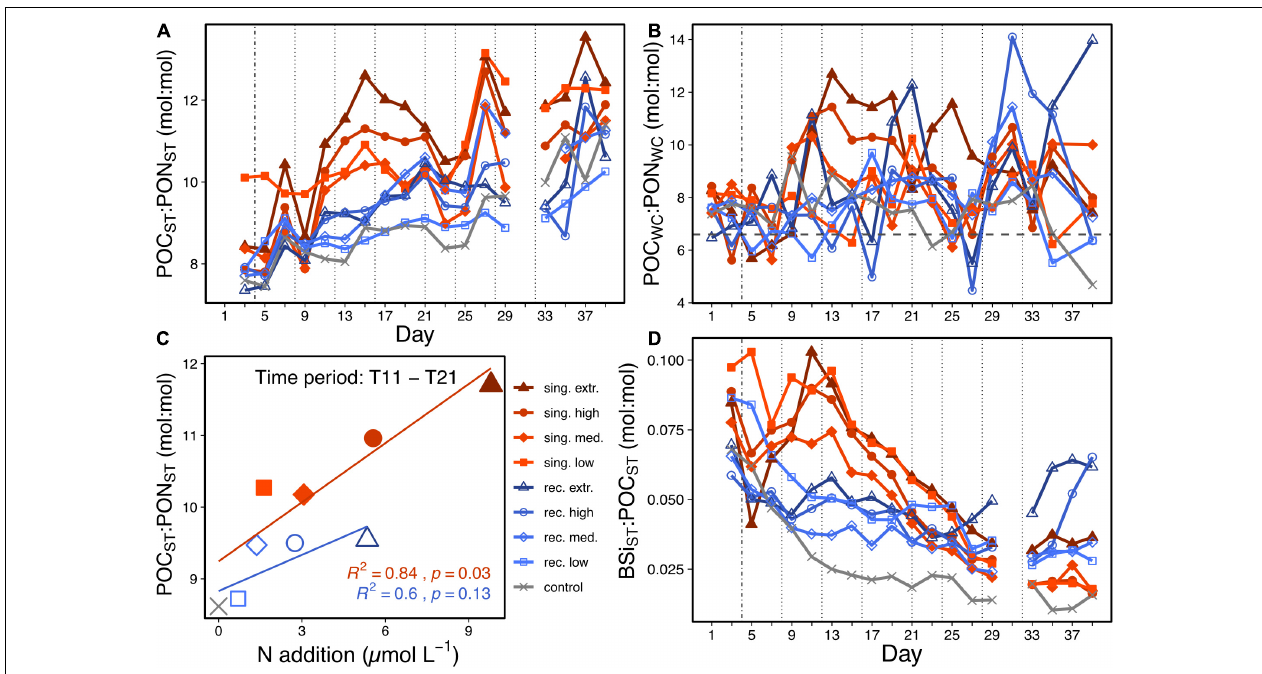
FIGURE 3 | C:N ratios of the mass flux to the sediment trap (A) and suspended particulate matter C:N ratios (B) over time. The horizontal line in (B) indicates the C:N Redfield ratio of 6.6. (C) Displays the correlation between the mean C:N ratio of the mass flux and the mean cumulative N addition. It considers the time frame of the singular bloom export event (T11–T21), from which means over time were calculated. Regression lines are plotted in the color of the corresponding upwelling mode (singular or recurring). Regression equations are provided in Supplementary Table 1 . (D) Shows the mass flux Si:C ratios over time. The vertical lines are used as described in Figure 2 . TABLE 2 | Mean (cid:49) TOC WC and (cid:54) POC ST values, as well as (cid:49) TOC WC : (cid:54) POC ST ratios calculated from T33, T35, and T39. Upwelling mode Control Singular Recurring Upwelling intensity